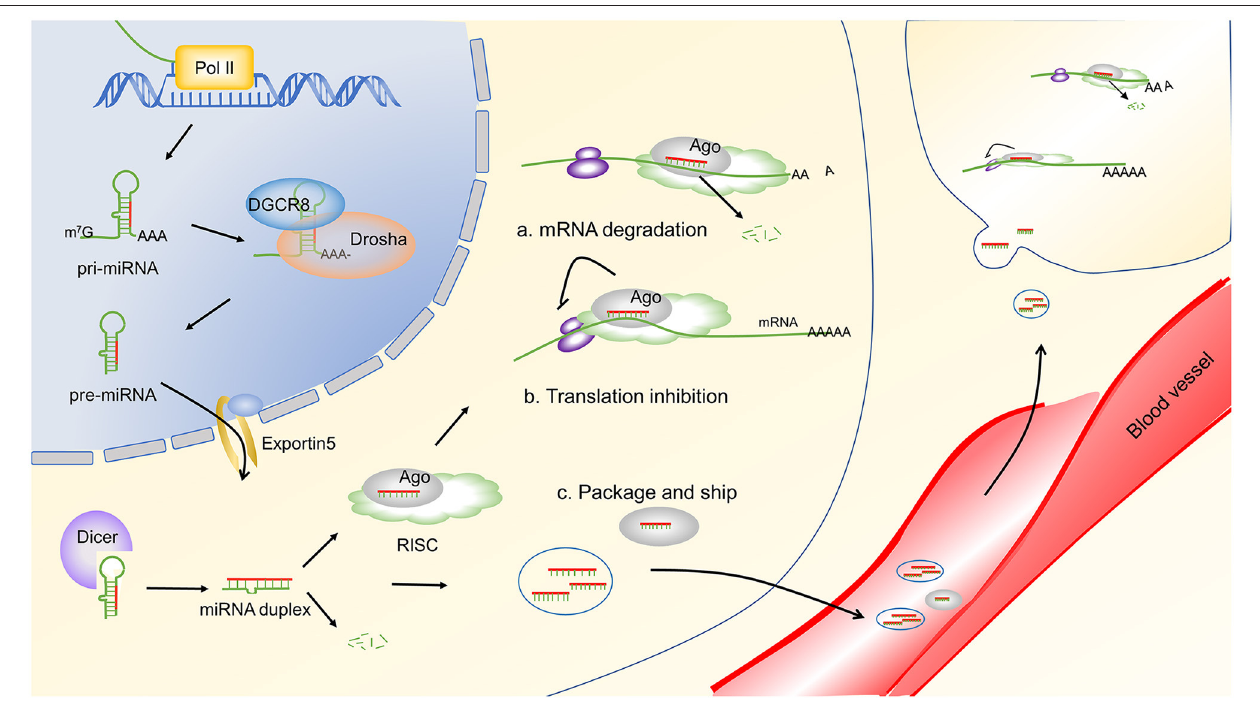
FIGURE 1 | miRNA biogenesis and function. miRNA genes are transcribed by RNA polymerase II (Pol II) to generate pri-miRNAs. Then, the pri-miRNAs were cleaved to be mature miRNAs through a serious of steps. The first step is mediated by the DGCR8 complex, which generates the pre-miRNA. Then, the pre-miRNAs are exported to the cytoplasm by exportin 5. In the cytoplasm, pre-miRNAs are cleaved by Dicer to produce ∼ 22 nucleotides of duplex miRNAs. One strand of the resulting duplex is bound by Ago proteins to form a RISC, and the other strand is commonly degraded. Finally, the mature miRNA guides the RISC to target mRNAs through complementary base pairing and represses target gene expression by either destabilizing target mRNAs (A) or repressing their translation (B) . Alternatively, miRNAs can be packaged into vesicles and transported to other cells to exert their function (C) . Arrow heads indicate a downstream response, and blunt lines indicate inhibition. Pol II, RNA polymerase II; m7G, 7-methylguanosine-cap; AAA, poly(A) tail; pri-miRNA, primary miRNAs; pre-miRNA, precursor miRNA; DGCR8, DiGeorge syndrome critical region gene 8; Ago, argonaute; RISC, RNA-induced silencing